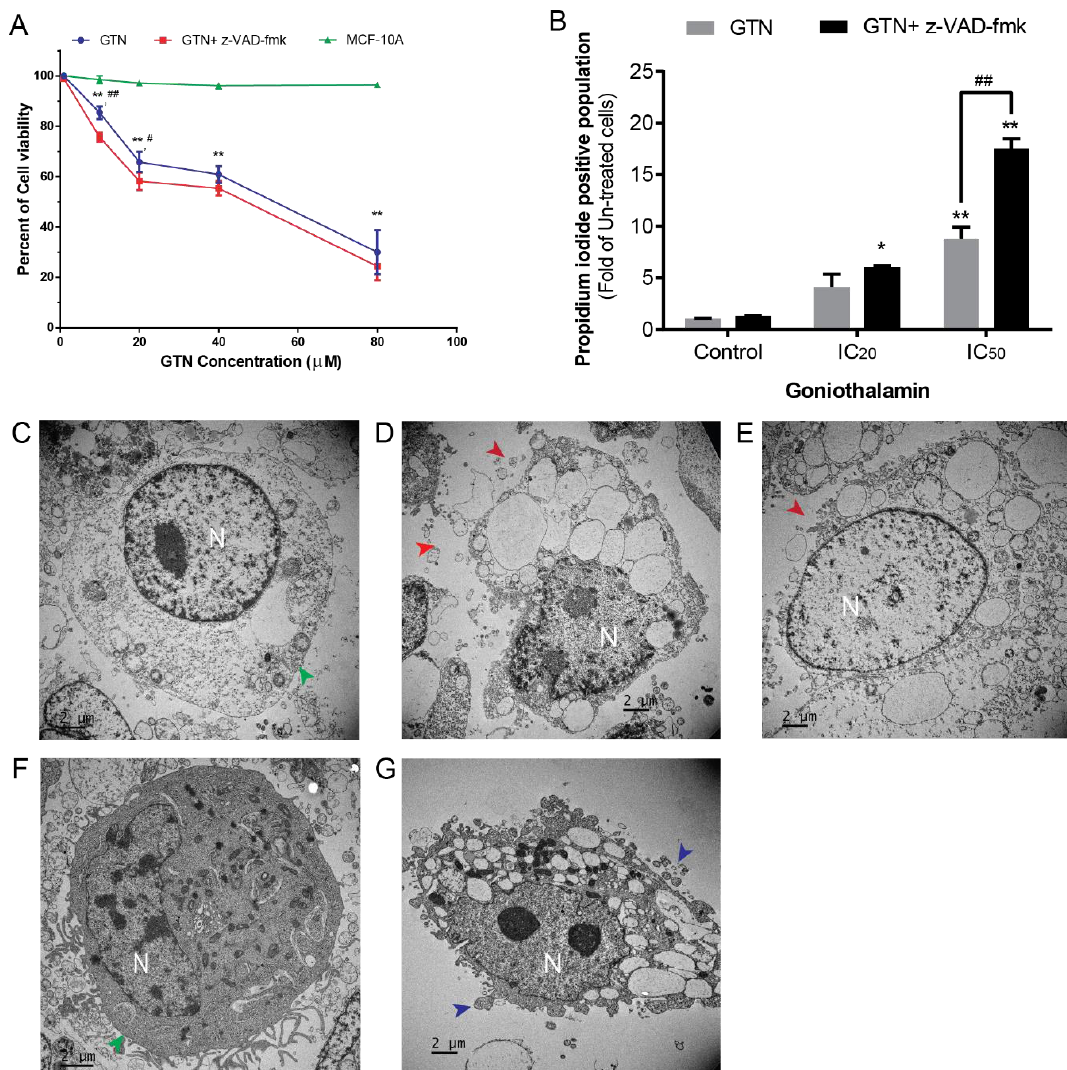
Figure 1. The cytotoxic effect and necroptosis induction of GTN on MDA - MB - 231 cells . The cell The cytotoxic e ff ect and necroptosis induction of GTN on MDA-MB-231 cells. viability of goniothalamin ( GTN ) in the presence or absence of z - VAD - fmk against human breast The cell viability of goniothalamin (GTN) in the presence or absence of z-VAD-fmk against cancer MDA - MB - 231 cells and MCF-10A cells were determined by the MTT ((3-(4,5-dimethylthiazol- human breast cancer MDA-MB-231 cells and MCF-10A cells were determined by the MTT 2-yl)-2,5-diphenyltetrazolium bromide) assay ( A ). Percent of propidium iodide - positive cells in the ((3-(4,5-dimethylthiazol-2-yl)-2,5-diphenyltetrazolium bromide) assay ( A ). Percent of propidium condition with or without z - VAD - fmk at a GTN concentration of IC 0 , IC 20 , and IC 50 were measured iodide-positive cells in the condition with or without z-VAD-fmk at a GTN concentration of IC 0 , by annexin V - fluorescein isothiocyanate and PI staining followed by FACs ( B ). Transmission electron IC 20 , and IC 50 were measured by annexin V-fluorescein isothiocyanate and PI staining followed by micrograph of the untreated MDA - MB - 231 cell ( C ) compared to GTN co - treated with z - VAD - fmk FACs ( B ). Transmission electron micrograph of the untreated MDA-MB-231 cell ( C ) compared to ( D ) , 0 . 03 % hydrogen peroxide - treated cell as a positive control ( E ) , z-VAD-fmk - treated cell ( F ) and GTN co-treated with z-VAD-fmk ( D ), 0.03% hydrogen peroxide-treated cell as a positive control ( E ), GTN - treated cell ( G ) (N = nucleus, green arrowhead = intact membrane, red arrowhead = collapsed z-VAD-fmk-treated cell ( F ) and GTN-treated cell ( G ) (N = nucleus, green arrowhead = intact membrane, membrane and blue arrowhead = blebbing membrane). The results were collected from three red arrowhead = collapsed membrane and blue arrowhead = blebbing membrane). The results independent experiments in triplicate, the significance of statistical values compared to the control were collected from three independent experiments in triplicate, the significance of statistical values ( without treatment ) are marked with * p < 0 . 05; ** p < 0 . 01, and compared to GTN alone are marked compared to the control (without treatment) are marked with * p < 0.05; ** p < 0.01, and compared to with # p < 0 . 05; ## p < 0 . 01 . GTN alone are marked with # p < 0.05; ## p <